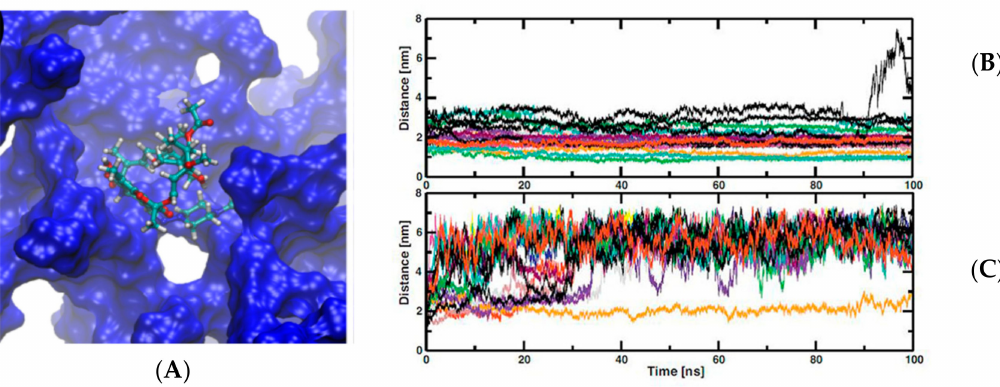
Figure 4. ( A ) a rifampicin (RIF) molecule inside one cavity of PAMAM dendrimer from molecular dynamic trajectory. ( B , C ) charts time of simulations against distance between center of mass of RIF molecules and dendrimer center of mass. ( B ) at neutral pH and ( C ) at low pH. This Figure was